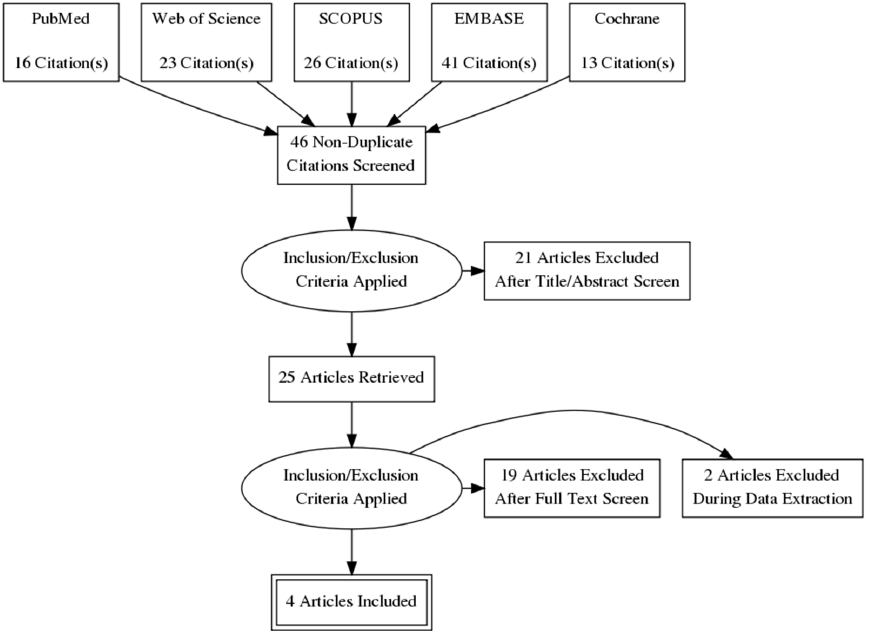
Figure 2. PRISMA flowchart.